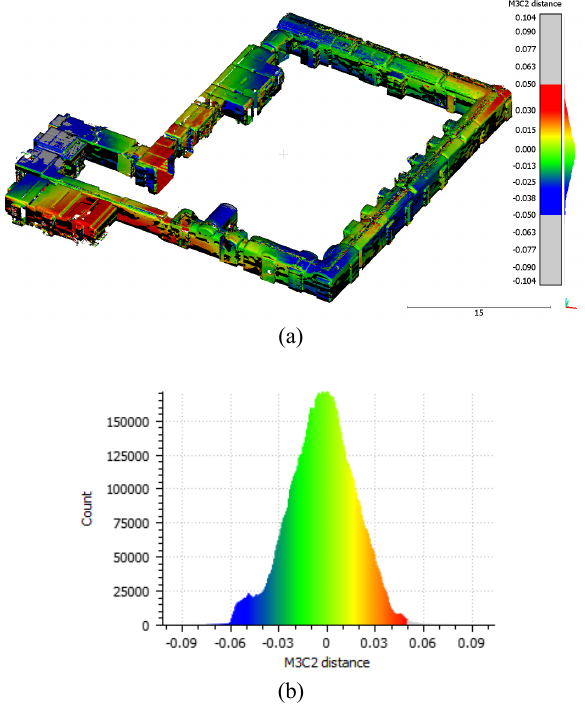
Figure 5. Result of the comparison with M3C2 distances (in meters): (a) point cloud colorized according to distances, (b) associated